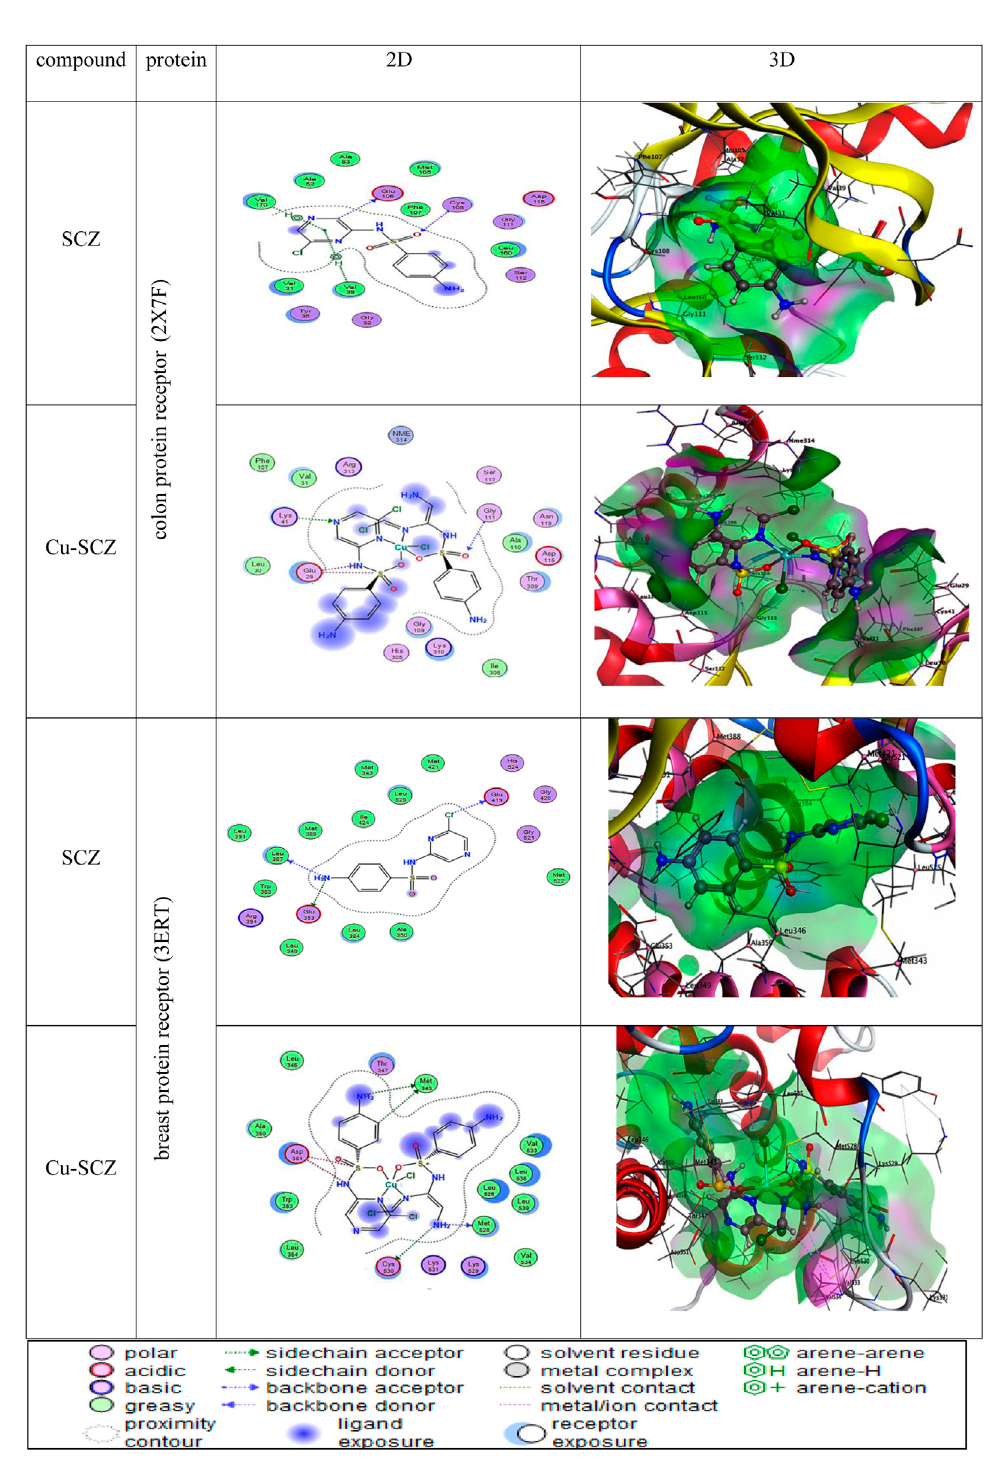
TABLE 5 | 2D and 3D molecular docking mode and interaction between SCZ and the Cu(II) complex with the colon protein receptor (2X7F) and the breast protein receptor (3ERT).